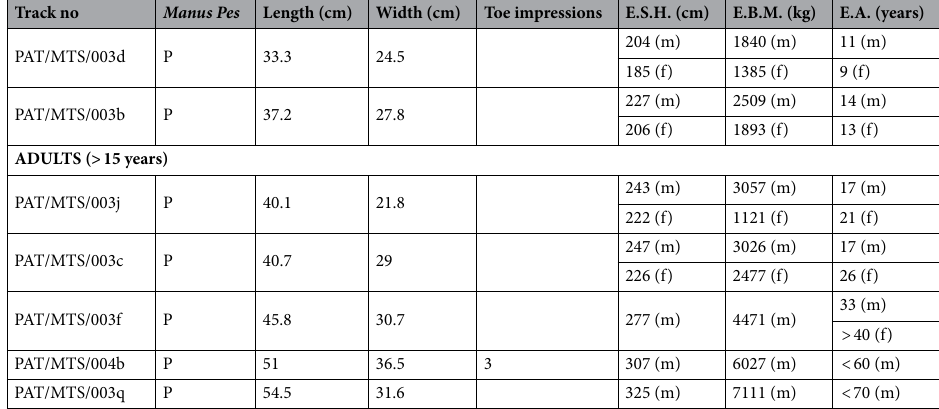
Table 1. Measurements of Proboscipeda tracks, ordered from smallest to largest in length. Pes measurements were preferred in trackways but due to the relatively small sample of different sized-producers, manus dimensions were also included, especially in isolated tracks. PAT/MTS— Palaeoloxodon antiquus tracks/ Matalascañas Trampled Surface, a, b, c, …—representing tracks with different sizes/individuals in the same